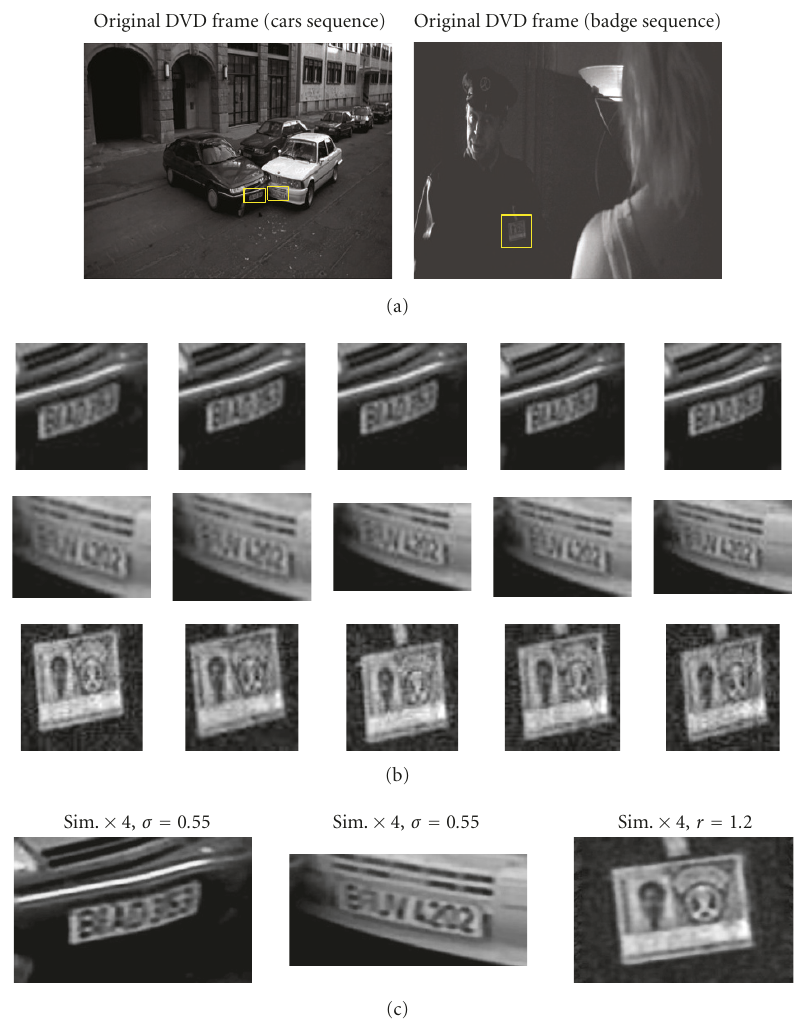
Figure 8: Results from the simultaneous super-resolution, image registration, and prior parameter updating scheme applied to the movie Lola Rennt on DVD. (a): two raw DVD frames. (b): five low-res frames from each sequence (black car’s number plate, white car’s number plate, security guard’s ID badge). (c): the same image regions super resolved using the simultaneous method. In the case of the security guard’s ID badge, intensities have been scaled for ease of viewing. Please refer to the text for notes on the aspect ratios involved when working with DVD